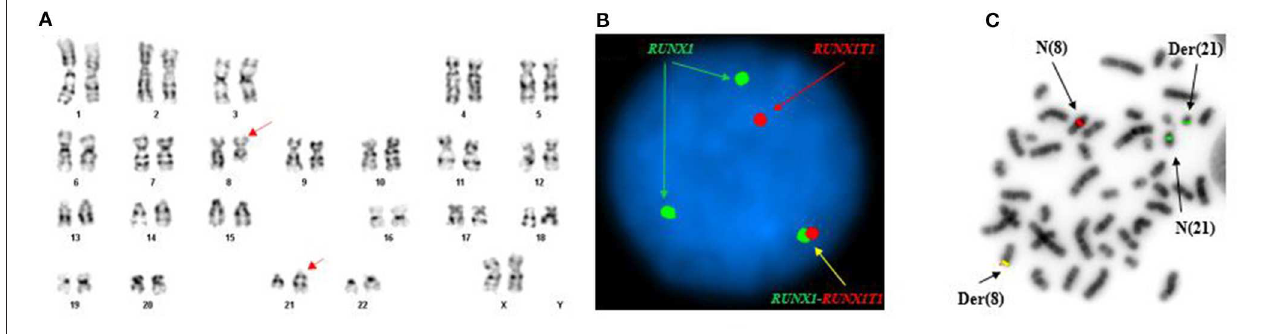
FIGURE 1 | Abnormal cytogenetic and FISH findings in Patient #1. (A) Representative karyogram of an apparent t(8;21)(q22;q22) observed in 11 of 20 metaphases analyzed, unable to show submicroscopic small deletions due to cytogenetic technic limitation. The aberration was re-written as der(8)t(8;21)(q22;q22),der(21)del(8)(q22q22)t(8;21) based on FISH findings in (B,C) . Arrows indicate aberrant chromosomes. Chromosome numbers are listed on the bottom. (B) Interphase FISH study using dual color dual fusion probes demonstrating an atypical pattern with one fusion signal for RUNX1-RUNXT1, one signal (red) for the RUINX1T1 locus, and two signals (green) for the RUNX1T1 locus. (C) Metaphase FISH study using dual color dual fusion probes demonstrating a derivative chromosome 8 [der(8)] carrying a fusion signal of RUNX1T1 and RUNX1, a derivative chromosome 21 [der(21)] carrying the green colored RUNX1 signal alone consistent with a sub-microscopic deletion of the rearranged 8q22 segment encompassing the 5 ′ RUNX1T1, a copy of a normal chromosome 8 [N(8)] and a copy of a normal chromosome 21 [N(21)].